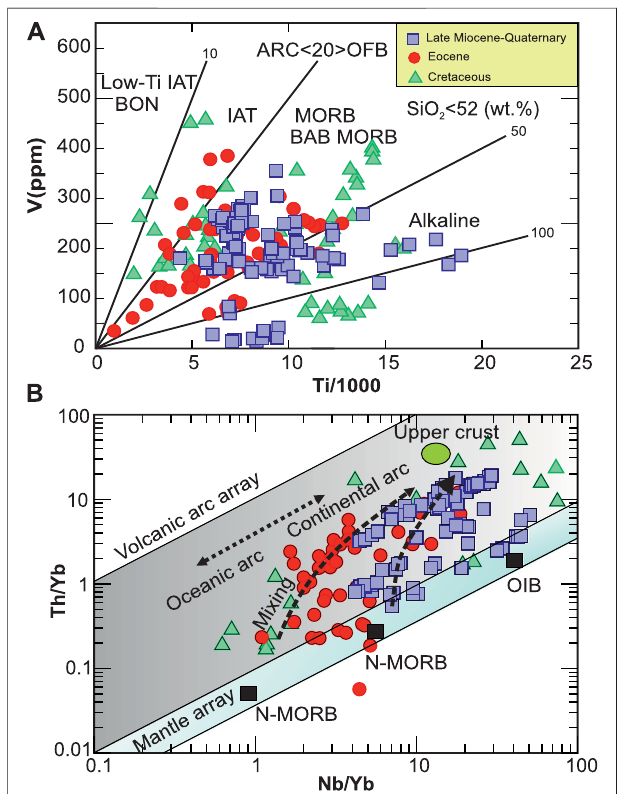
FIGURE 6 | Distribution of basic rocks (SiO 2 less than 52 wt%) from the southernand westernCaspianSeawithdifferentagesfromtheCretaceousto Quaternary in the Ti – V Diagram (Shervais, 1982) and Th/Yb vs. the Nb/Yb diagrams (Pearce, 2008) in a and b, respectively. The ma fi c rocks plot near the arc and back-arc fi elds in the Ti – V diagram, and the higher ratios of the Th/Yb ratios plot in the volcanic-arc fi eld in the Nb/Yb-Th/Yb ratios. See the text for more information and referencesfor the data. For source data, see Supplementary S2 . Abbreviations: MORB (cid:1) Mid-Oceanic Ridge Basalt; BAB (cid:1) Back Arc Basalt; IAT (cid:1) Island Arc tholeiite; BON (cid:1)